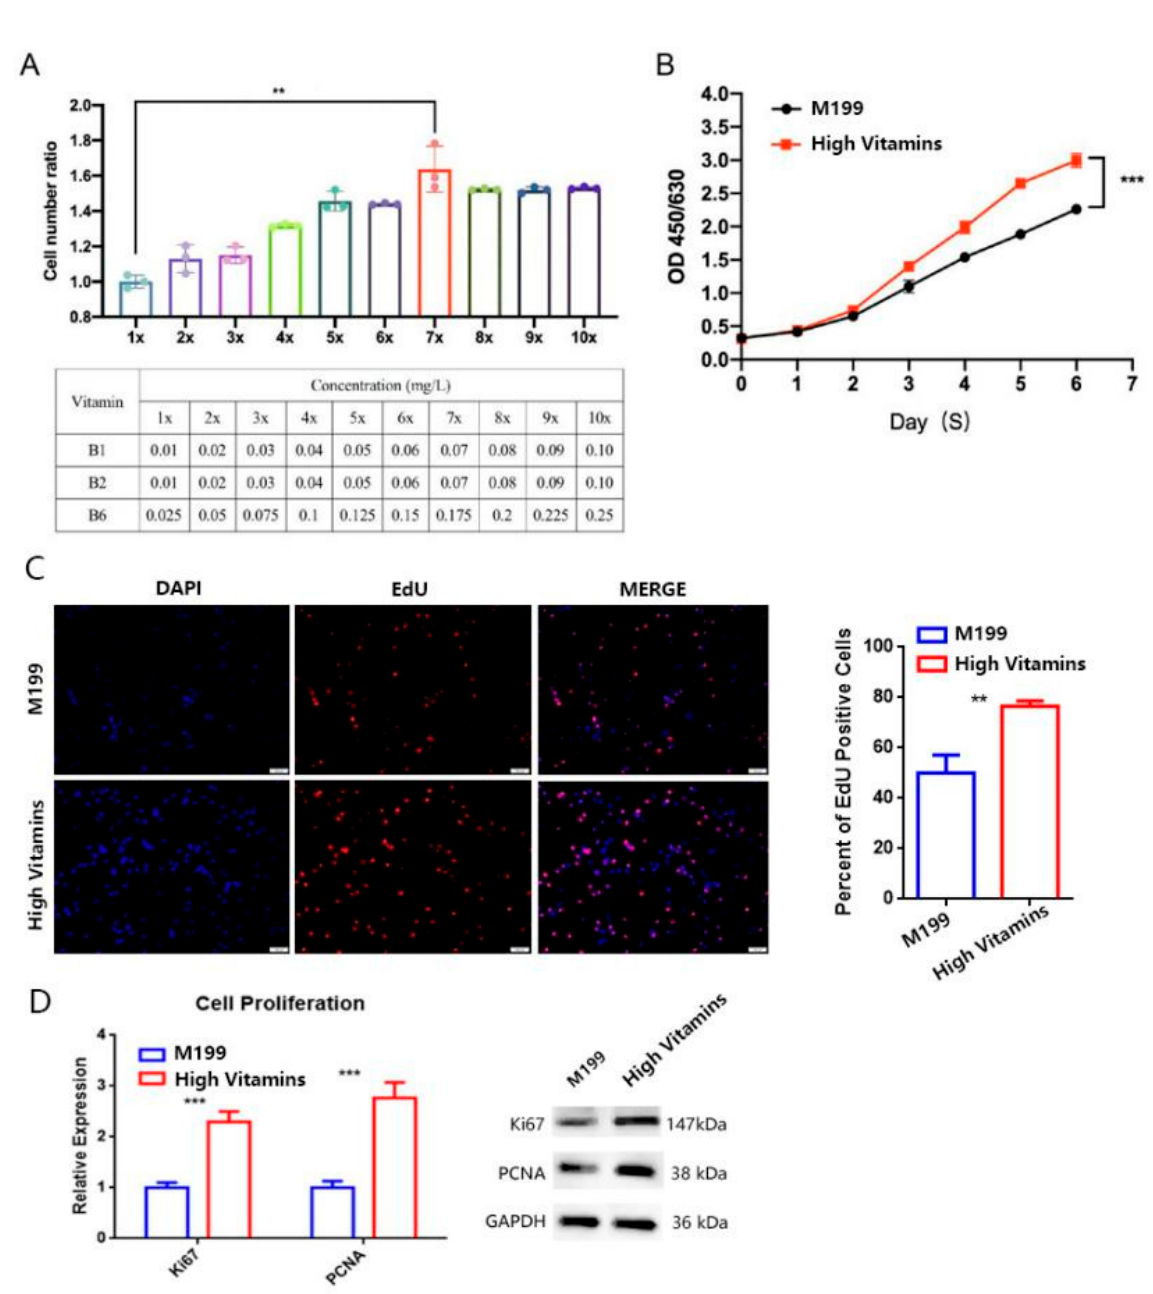
Figure 1. Vitamins supplements promote Vero cell proliferation. ( A ) Effect of different vitamin concentrations on Vero cell proliferation. Different concentrations of vitamin B were added to Vero with the same density. After 96 h of culture under the same conditions, the total number of cells was detected by CountStar. The cell number ratios were calculated and the histogram was drawn for t -test. ( B ) Cell proliferation curve detection. Using CCK8 reagent to detect the OD450/650 of Vero cells at the designated time point and draw the proliferation curve, t -tests were counted on day 6. ( C ) Effect of cell proliferation by EdU test. The cells were stained with EdU (red) and DAPI (blue). The percentage of Edu-positive cells is shown on the right and the histogram was drawn for the t -test. ( D ) Vitamins supplements improve the expression of PCNA and Ki67 both of mRNA ( left ) and protein ( right ) level expression. Housekeeping gene GAPDH is an internal reference. Error bars represent SEM. ** p < 0.01; *** p < 0.001. 2.2. Transcriptomics Revealed Vitamin B Affected Metabolic Pathways in Vero Cells To further confirm the mechanism of action of vitamin B, we conducted tran- scriptomic studies on three replicate Vero cell samples in the high vitamin medium group and the normal medium group. First, the expression values of all genes or transcripts in each sample were calculated, and the expression levels of transcripts in different samples were displayed by box plots (Figure 2A), indicating that the transcript samples were con- sistent. After the quantitative analysis was completed, the expression matrix of all samples was obtained, and we analyzed the differential genes. Among them, compared with the normal medium group, the high vitamin medium group had a total of 269 genes, and 327 genes were down-regulated, which were displayed by the volcano plot (Figure 2B). We clustered differential genes with similar expression patterns, and the clustering results were represented by a heat map, as shown in Figure 2C. In an organism, different genes coordinate with each other to perform their biological functions. After classifying the GO terms enriched by differential genes, a histogram of GO enrichment was drawn (Figure 2D). GO can be divided into three parts: molecular function, biological process and cellular component. The most important biochemical